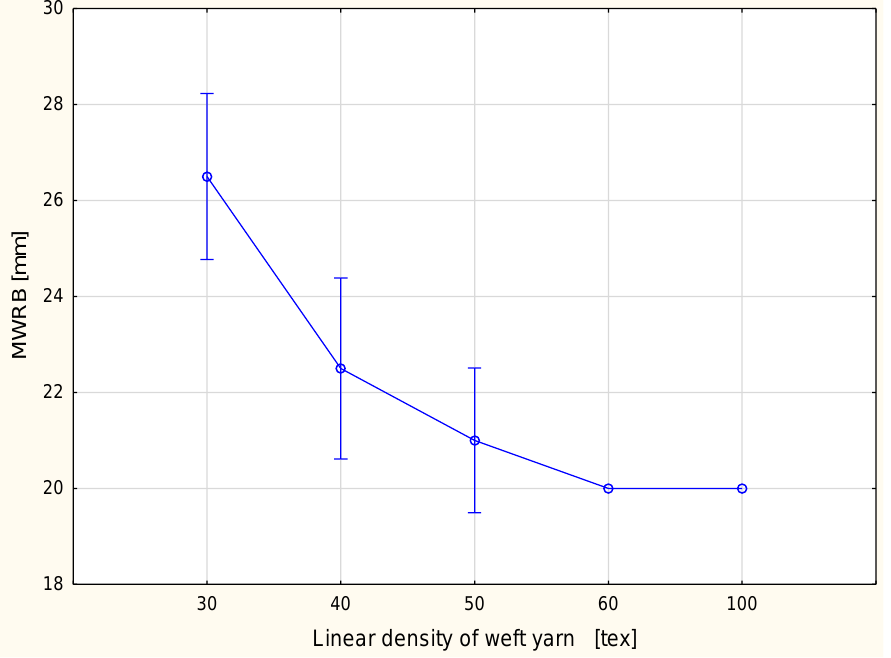
Figure 11. Maximum wetted radius for the bottom fabric surface vs. linear density of the weft yarn. It should be mentioned here that the wetted radius does not mean that the trace of moisture on the fabric surface had a round shape. The radius refers to the maximum radius of the sensor ring on which the presence of moisture was recorded.